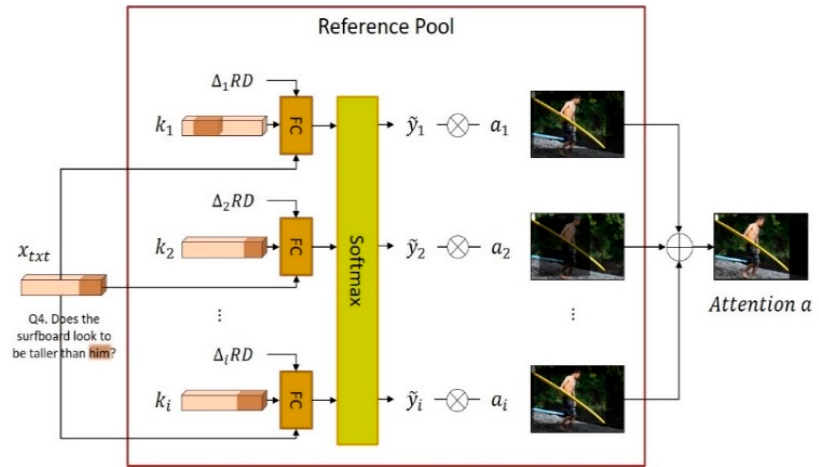
Figure 6. Reference pool and Refer module. Sensors 2021 , 21 , x FOR PEER REVIEW